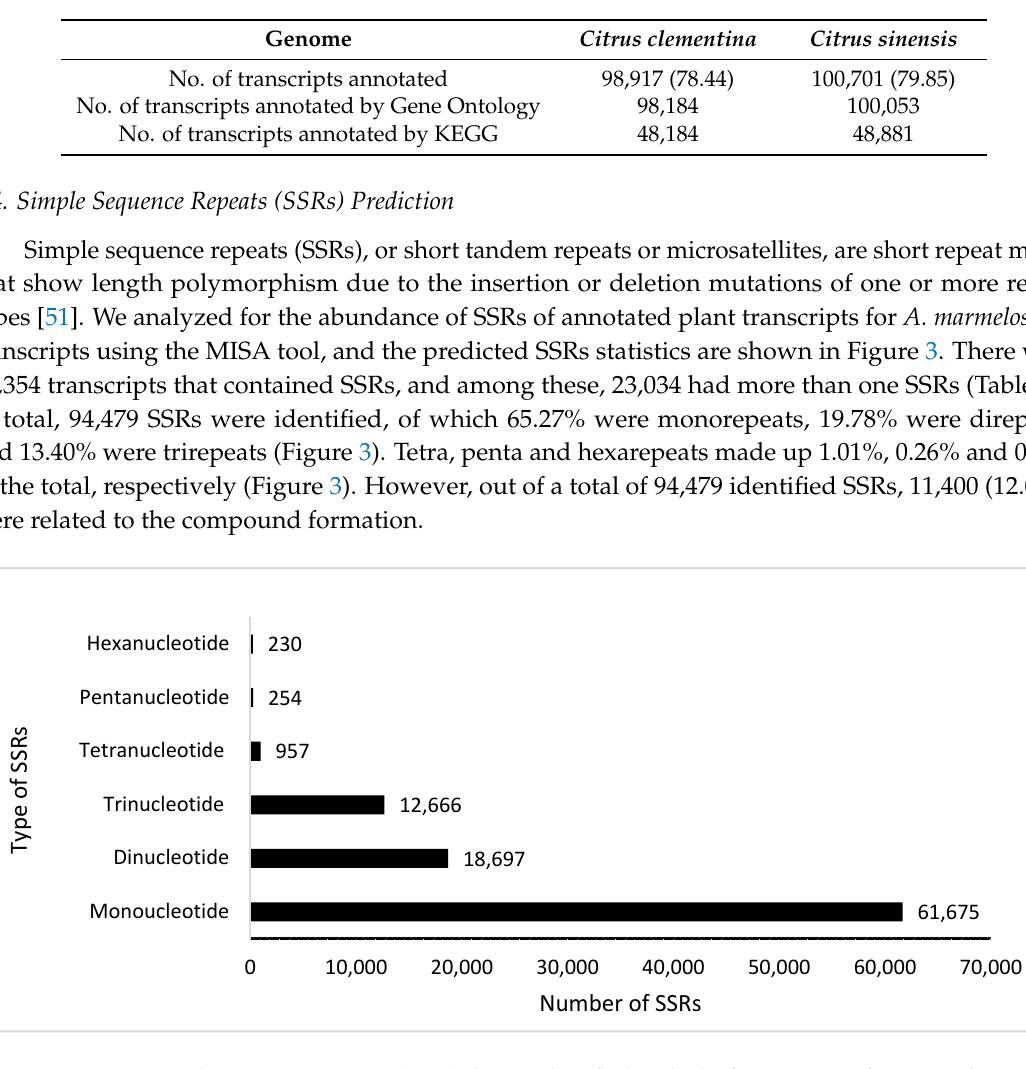
Table 3. Annotationsummaryof A.marmelos leaftranscriptswithCitrus sinensis and Citrusclementine genome.